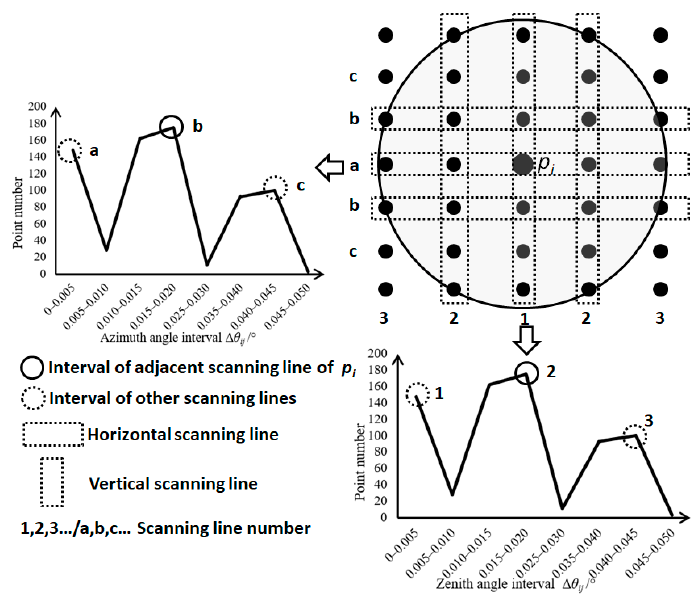
Figure 5. Example of the histogram of azimuth and zenith angle intervals.